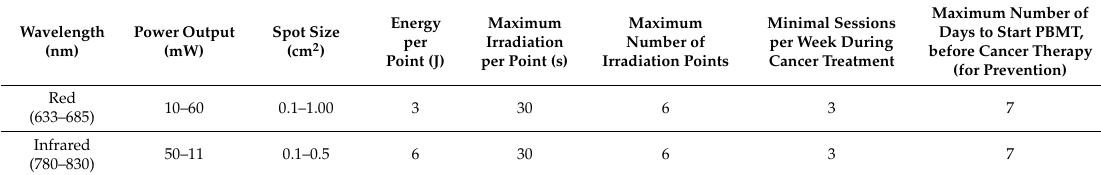
Table 2. Summarised recommended treatment parameters. Abbreviations: nm (nanometer), mW (milliwatt), J (joule), cm 2 (centimeter square), J (Joule), s (second). Wavelength (nm)